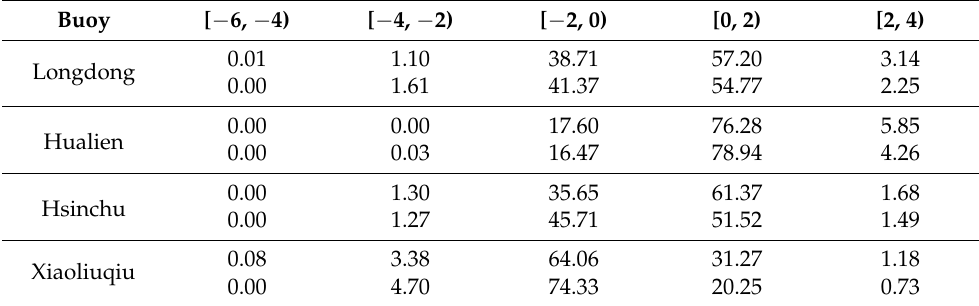
Table 2. Percentages of the model-data differences (units of seconds) for the peak wave period at different classes and buoys using winds from CFSR (upper) and CFSR_5km (lower).